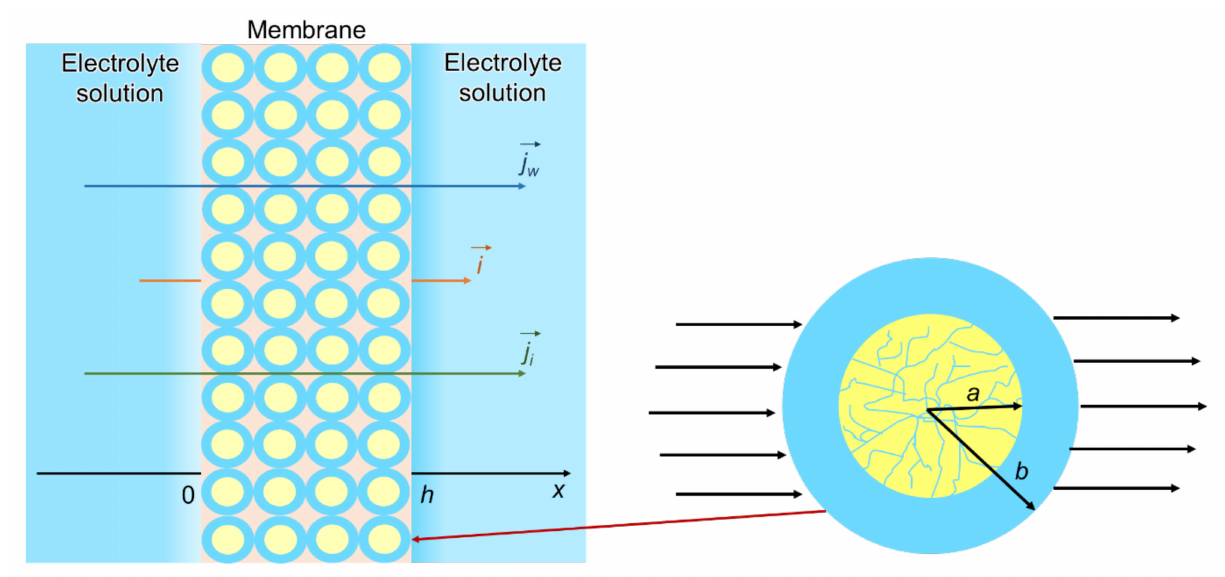
Figure 13. Schematic representation of a cell model, as described by Vasin et al.